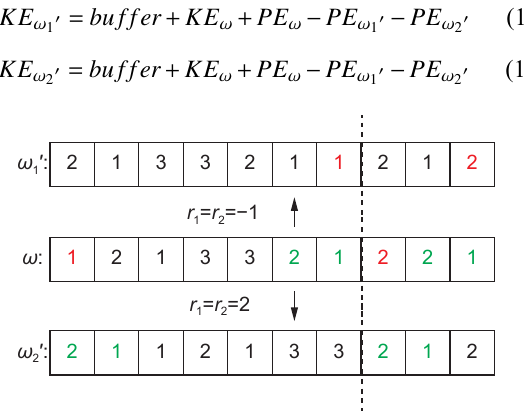
Fig. 5 Decomposition reaction diagram. Fig. 6 Inter-molecular ineffective collision